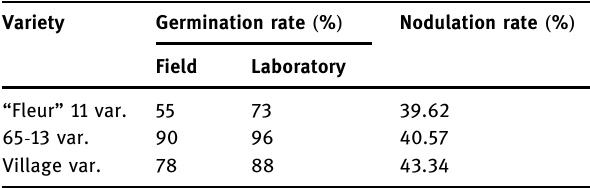
Table 2: Germination and nodulation rates of cultivated varieties